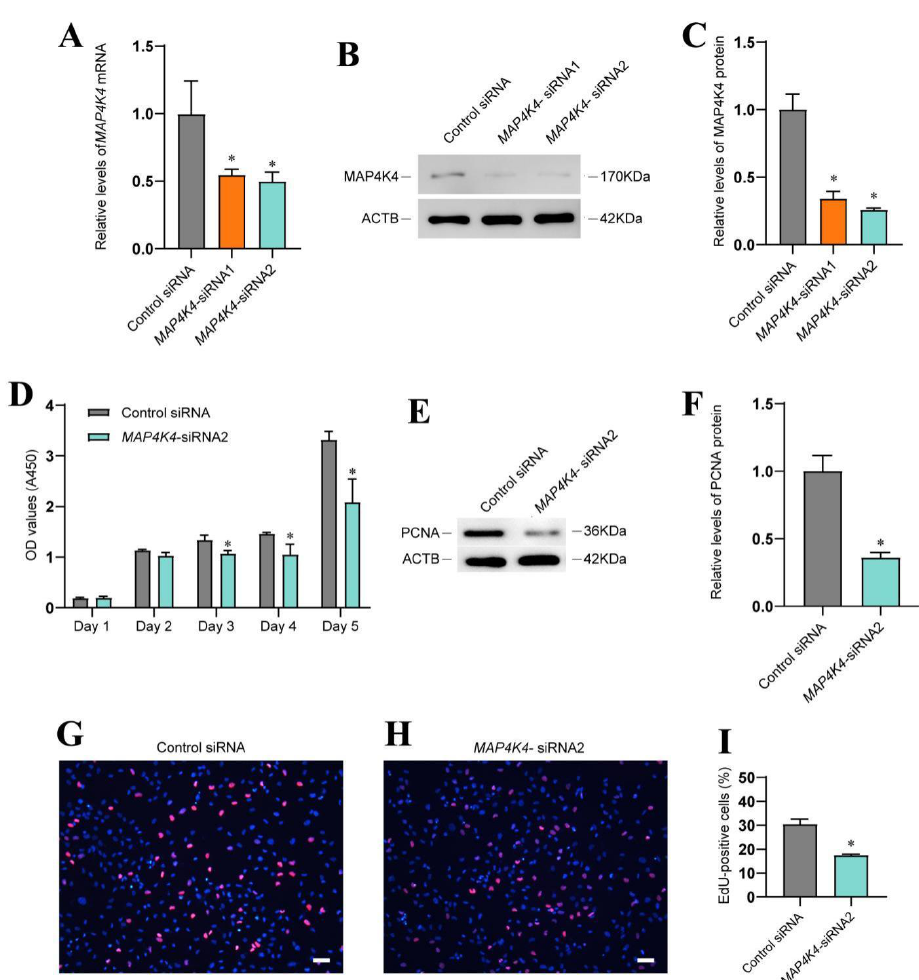
Figure 2. The influence of MAP4K4 knockdown on human SSC proliferation. ( A ) QPCR revealed MAP4K4 mRNA levels in a human SSC line after treatment with MAP4K4-siRNA1 and 2. ( B , C ) Western blotting showed MAP4K4 protein level changes in the human SSC line after the transfec- tion of MAP4K4-siRNA1 and 2. ACTB was used as the loading control for the total protein. ( D ) CCK-8 assay illustrated the proliferation of human SSC line transfected with the control siRNA and MAP4K4-siRNA2. ( E , F ) The relative levels of PCNA protein in human SSC line after transfection with the control siRNA and MAP4K4-siRNA2. ( G – I ) The percentages of EdU-positive cells in hu- man SSC line transfected with control siRNA and MAP4K4-siRNA2. Scale bars in G: 50 μm. * denote p < 0.05.